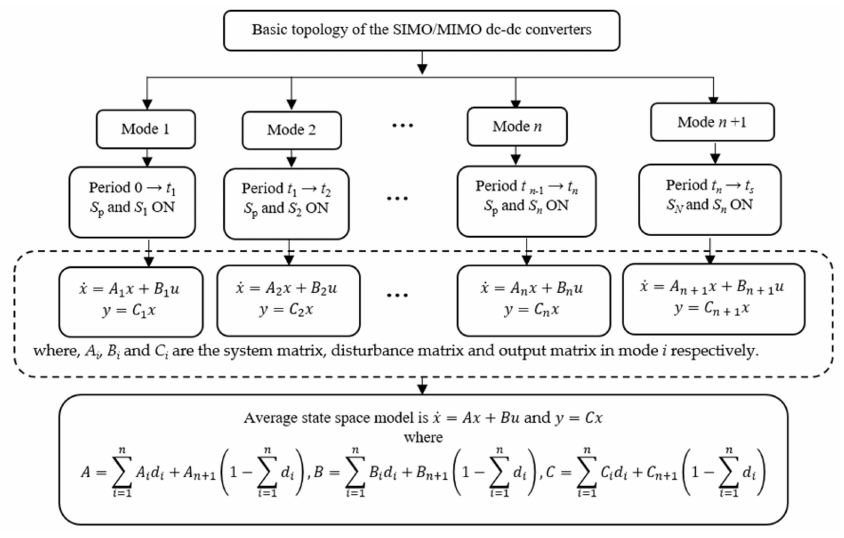
Figure 3. Block diagram of average state space